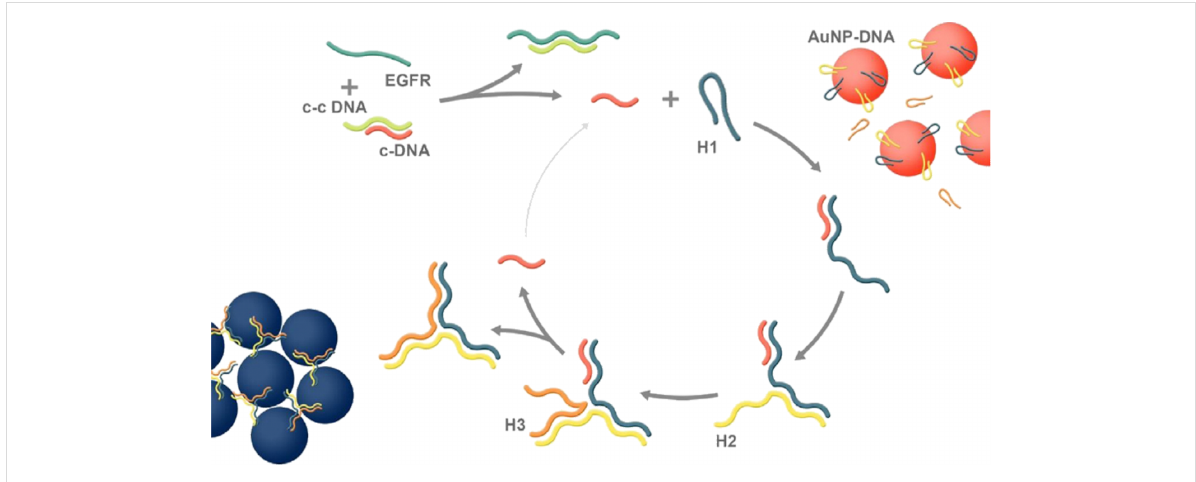
Figure 5: Working principle of the colorimetric assay for the detection of EGFR mutants in long DNA sequences. The presence of a target releases the catalyst oligonucleotide initiating CHA, which in turn progressively aggregate gold nanoparticles. Reprinted with permission from [81], copyright 2018 John Wiley and